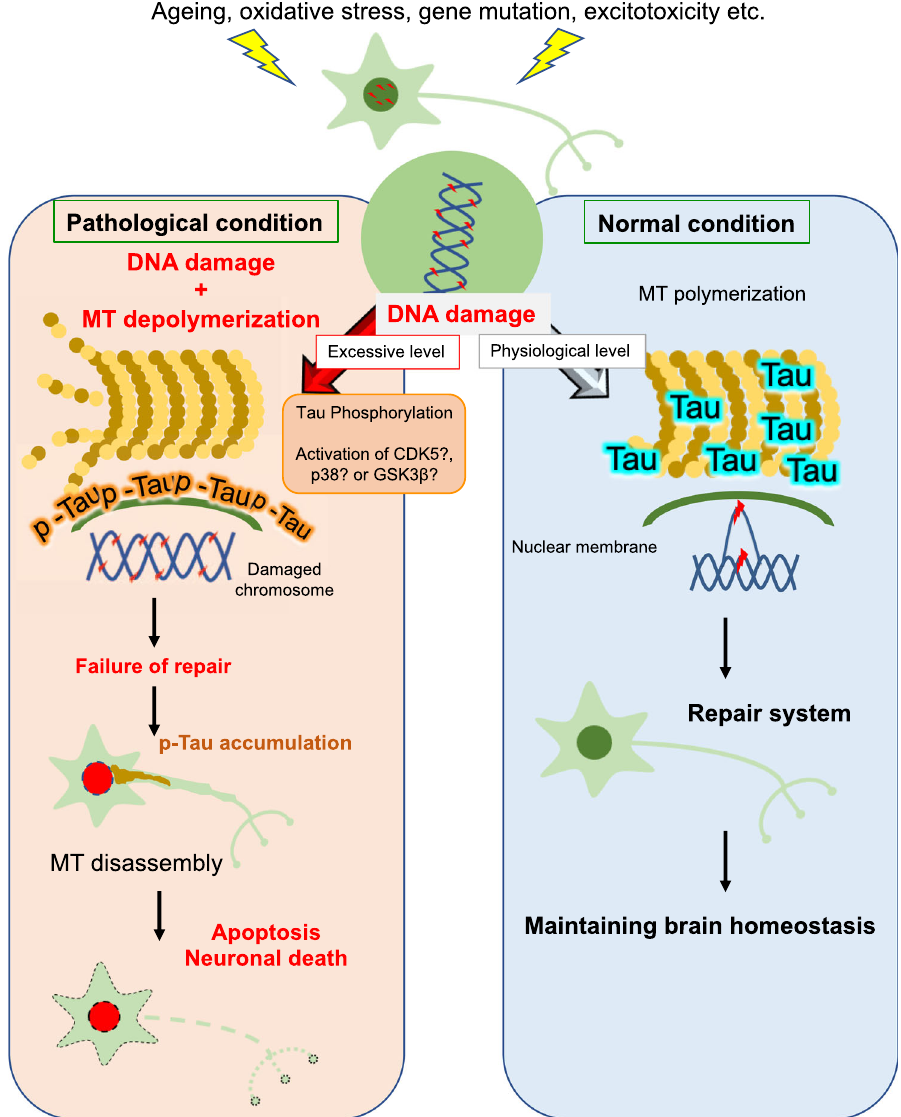
Fig. 8 Hypothetical model of neuronal death and DNA damage repair from the perspective of the relationship between tau and microtubule polymerization. Upon DNA damage, non-p-tau (blue) binds to microtubules at the physiological level, which promotes microtubule (MT) polymerization and induces accumulation around the perinuclear membrane to support DNA damage repair (Right: normal condition). When DNA damage reaches an excessive level, tau phosphorylation is enhanced and microtubule depolymerization occurs. Accumulation of p-tau (orange) around the perinuclear membrane suppress the movement of damaged chromosomes or inhibits the recruitment of DNA damage repair factors into the nucleus by inhibiting nuclear cytoplasmic transport. Subsequently, insolubule p-tau accumulates in the cytoplasm and axons, leading to further microtubule polymerization and neuron death (left: pathological